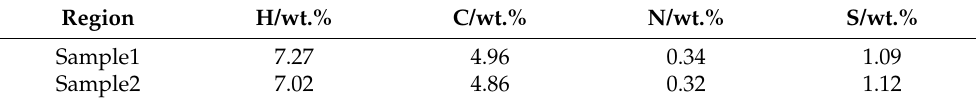
Table 3. Element analysis of Fuyu oil shale.